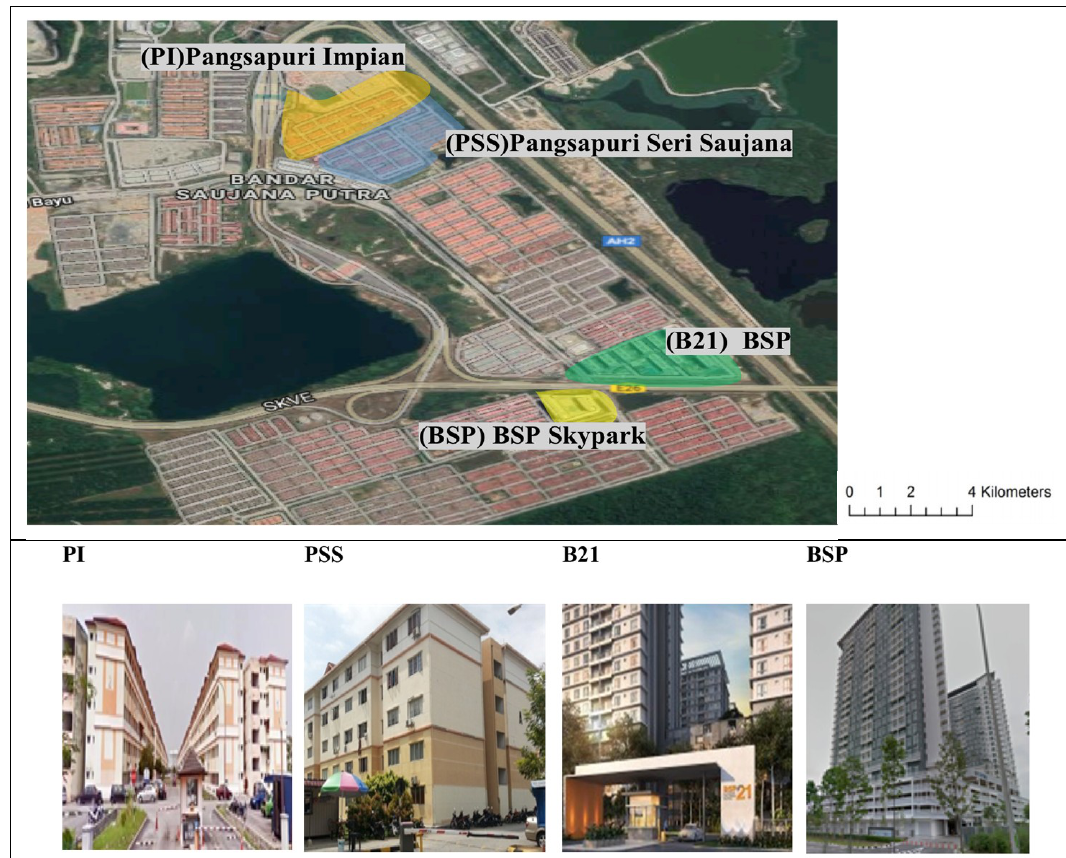
Figure 1. Sampling sites for four different localities of high-rise apartments in Bandar Saujana Putra; (PI) Pangsapuri Impian (orange), (PSS) Pansgapuri Seri Saujana (blue), (B21) BSP 21 (green) and (BSP) BSP Skypark (yellow).